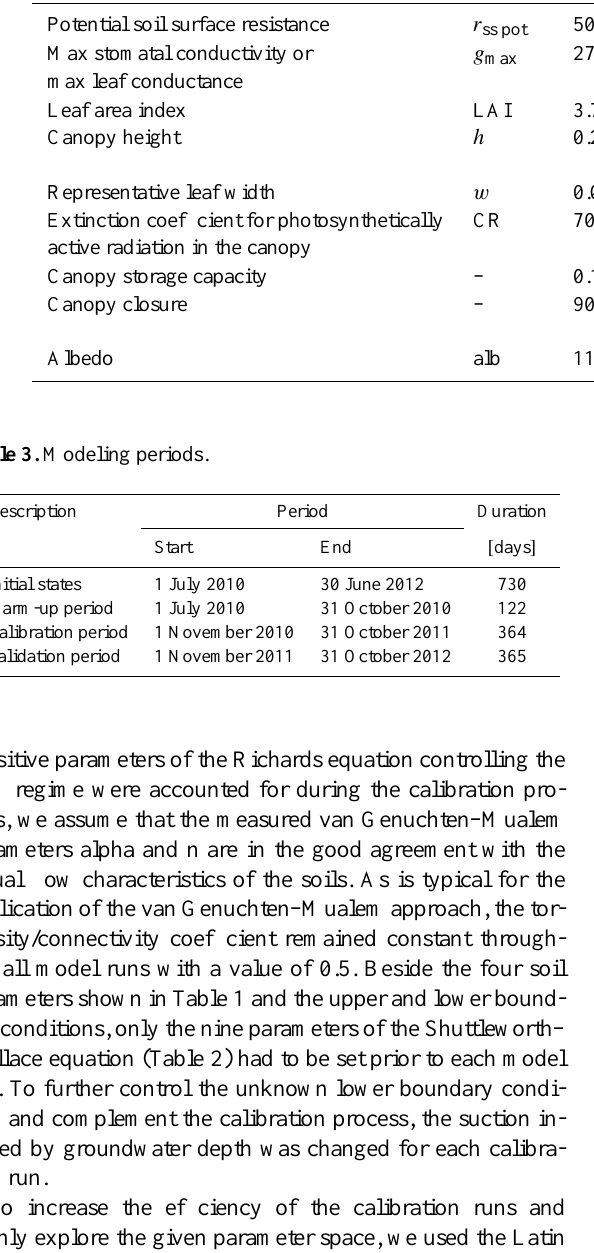
calculate hand measurements